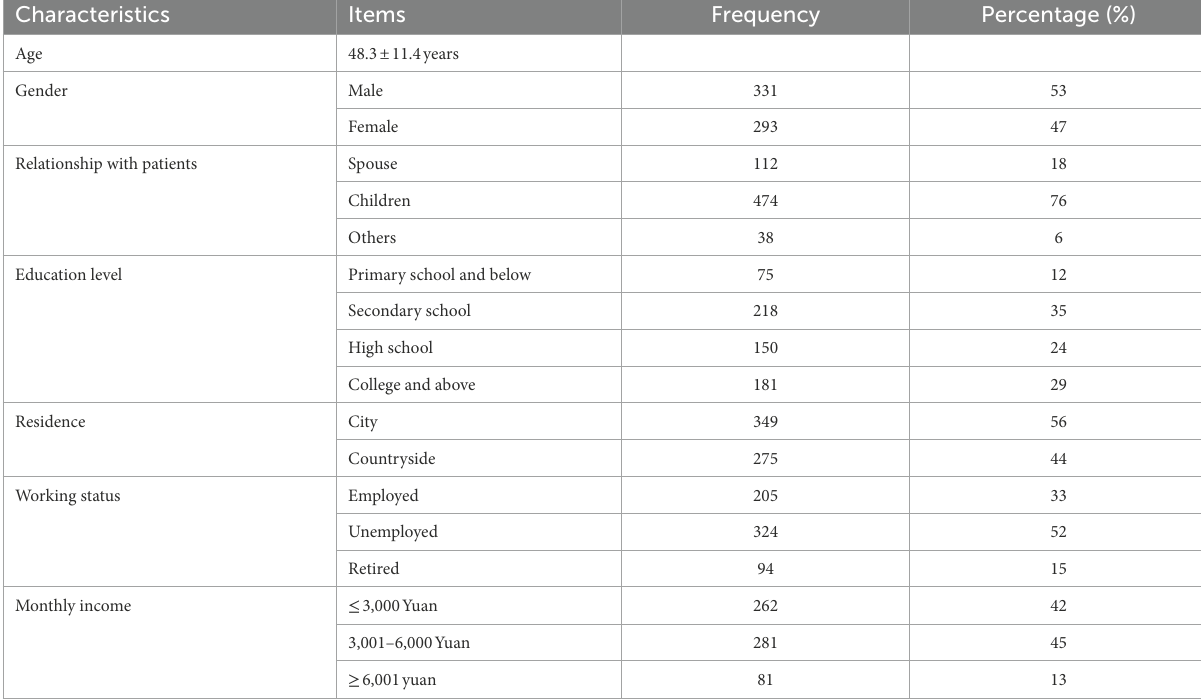
TABLE 1 Demographic characteristics of participants ( N =